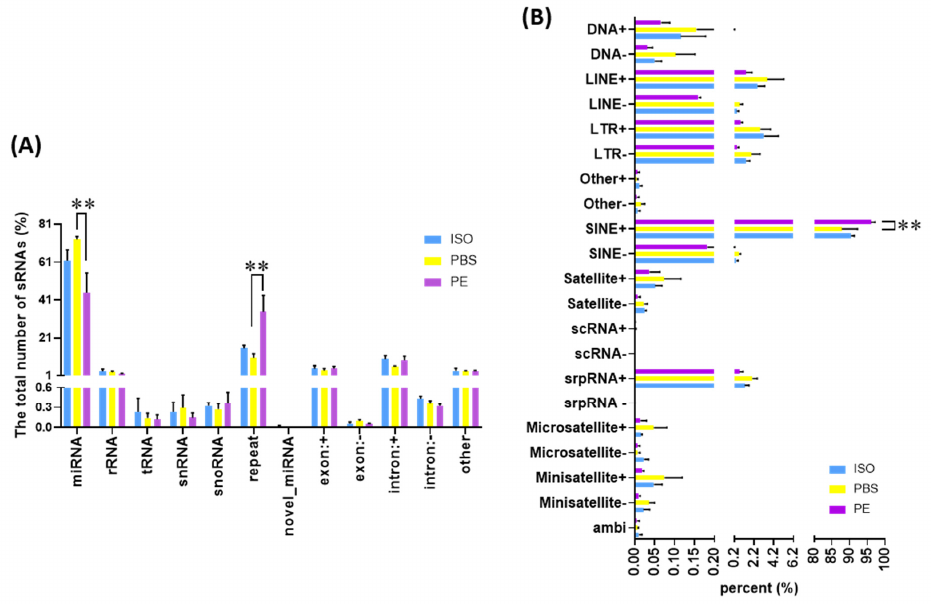
Figure 2. The frequency of annotated reads of small RNAs and the classes of genomic repeat in mouse blood extracellular vesicles (EVs) measured by noncoding small RNA sequencing: ( A ) Bar graph of the annotated small RNA species and their percentages in total read mapped to genome in mouse blood EVs with PBS, ISO (10 mg/kg/day) and PE (30 mg/kg/day) infusion for 1 week; ( B ) Bar graph of the classes of genomic repeat and their percent. PBS ( n = 3), ISO ( n = 3) and PE ( n = 3). Mean ± SD. ** p <